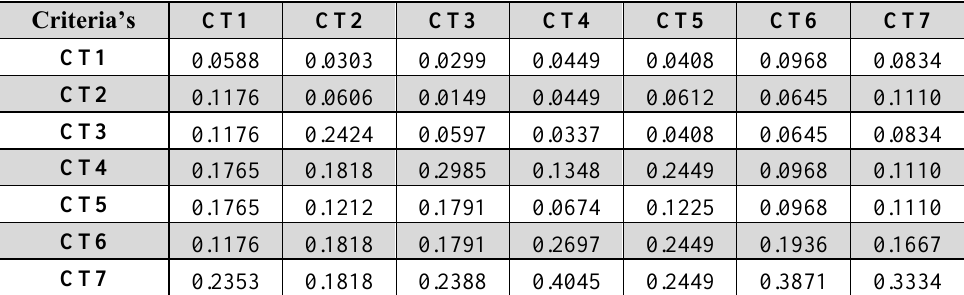
Table 3. Normalised Pair-wise matrix